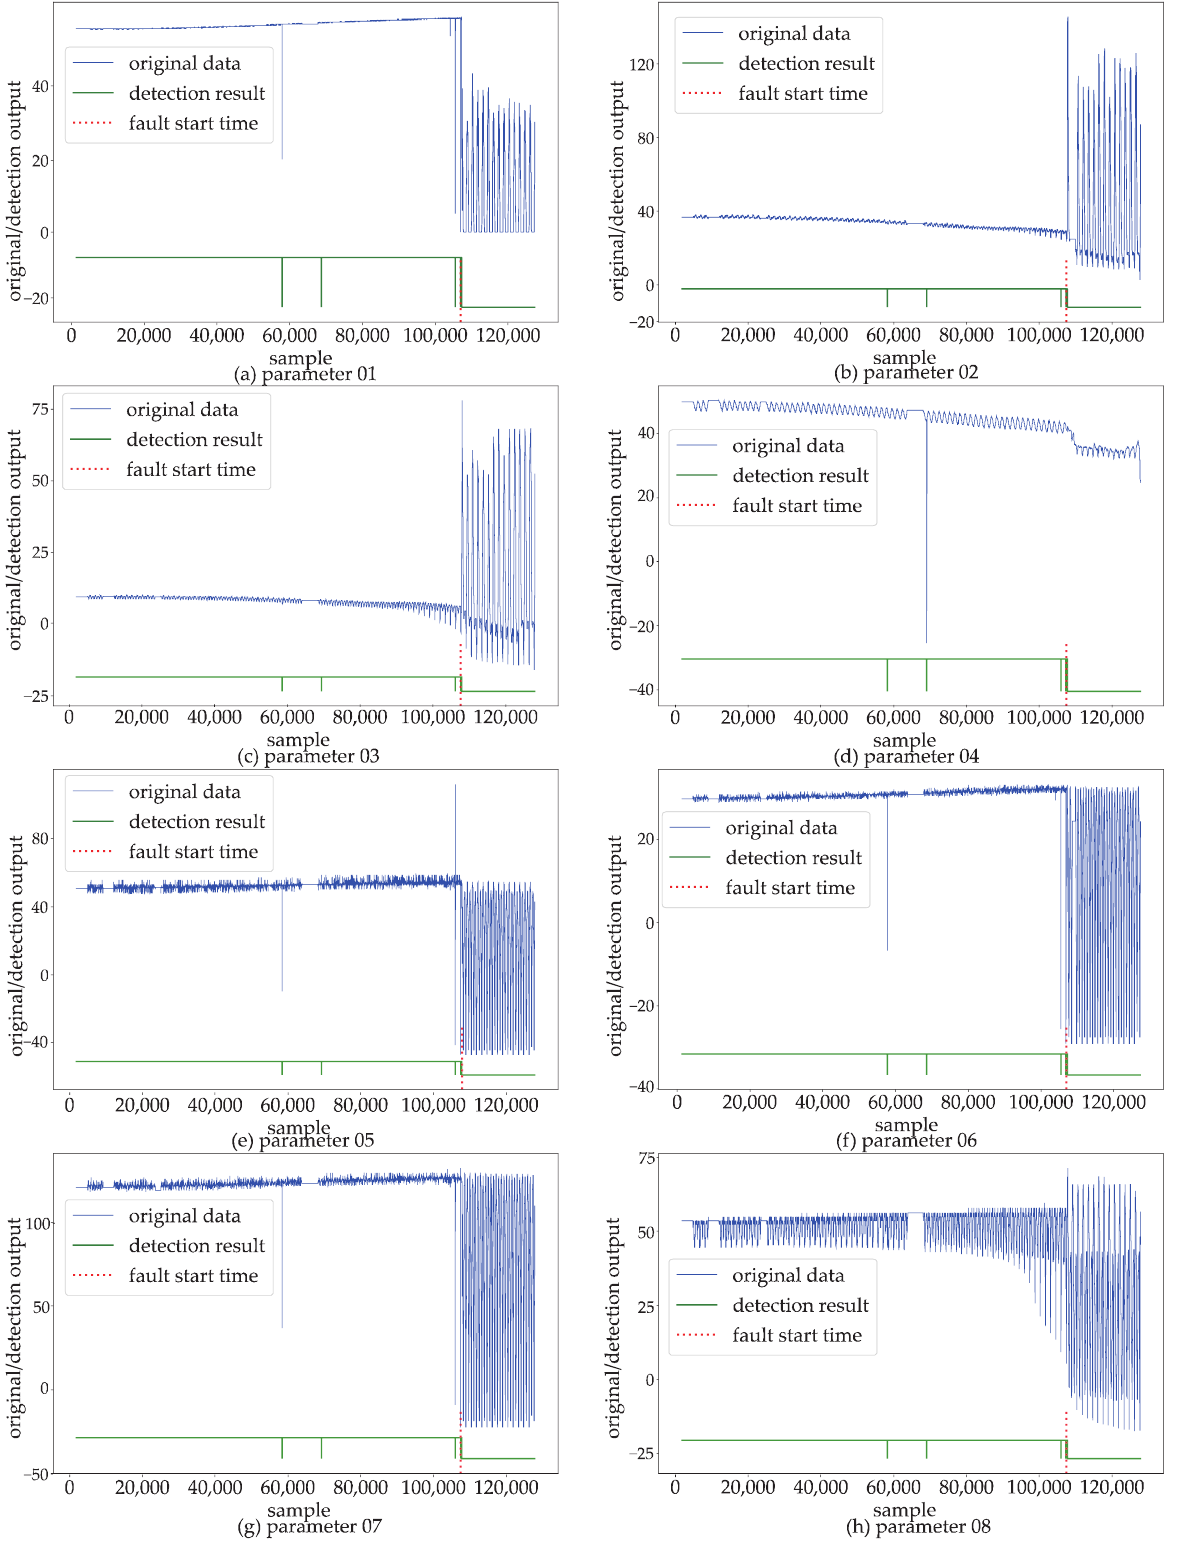
Figure 5. Detection results of the proposed MTAD method on test data set. “High” and “low” values indicate normal and anomalous results, respectively.